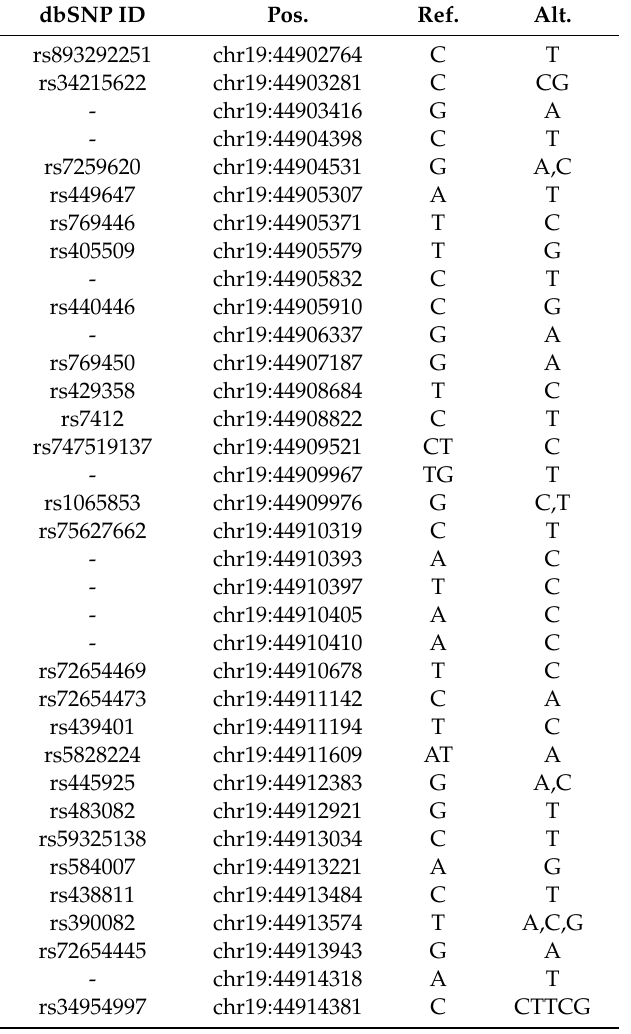
Table 1. Genetic variants in the region of interest. The columns show the identification code in dbSNP (dbSNP ID), the hg38-based coordinate positions (Pos.), and the reference (Ref.) and alternative (Alt.) nucleotides of each